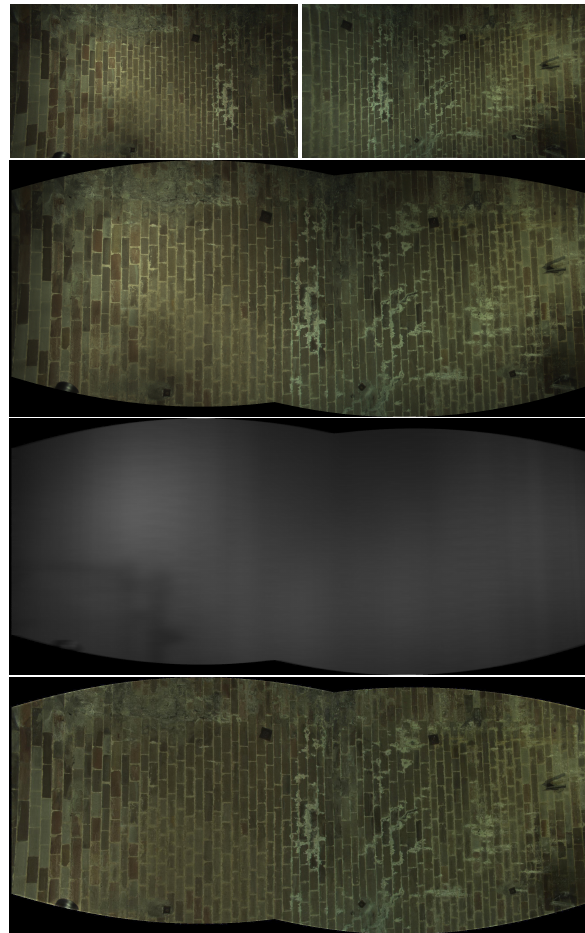
Figure 8: Example of panoramic image. From top to bottom: original images, combined image, “flat field” image exhibiting shadows and illumination variations, corrected panorama.